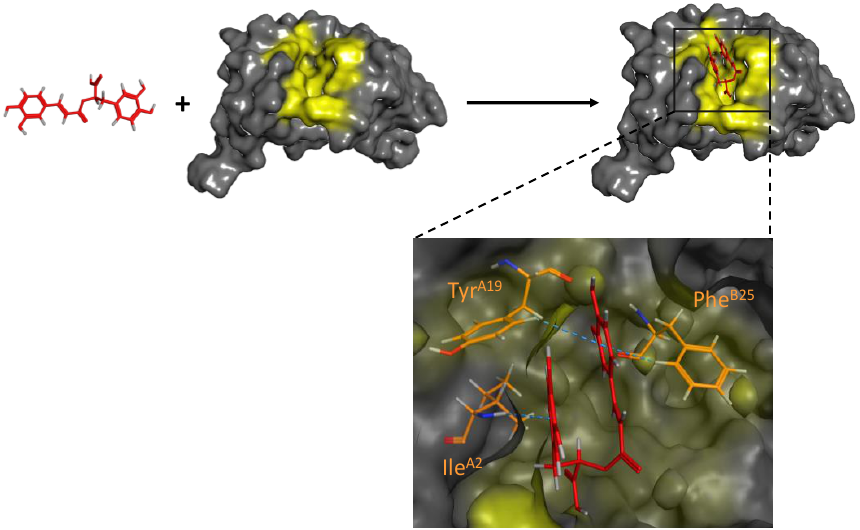
Figure 5. Rosmarinic acid undergoes conformational change from extended to bent conformation in binding to the hydrophobic pocket in insulin dimer. The formation of an aromatic cluster between bent rosmarinic acid and aromatic residues on the surface stabilizes the dimer, precluding amyloid formation.